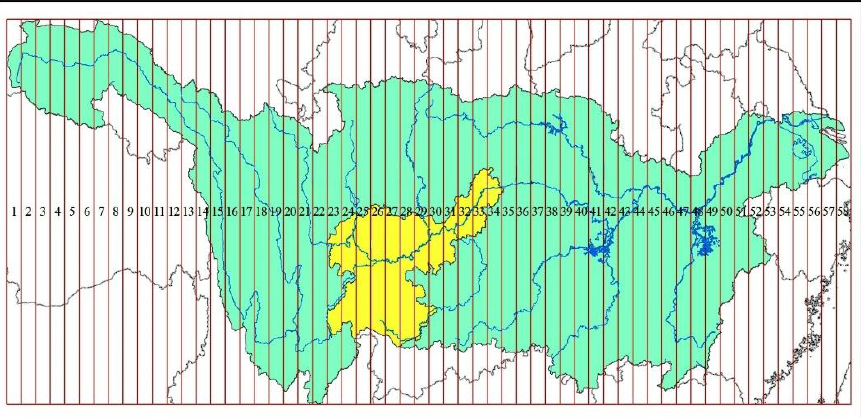
Figure 7. Radial zoning map of the study area and Yangtze River Basin (the green part is the Yangtze River Basin, and the yellow part is the study area.).